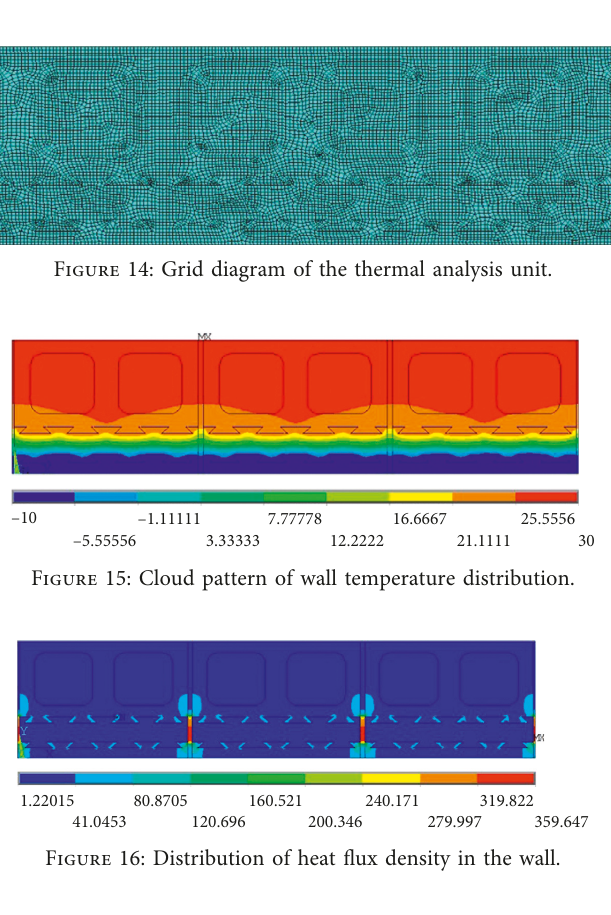
Figure 13: Geometric model of the thermal analysis unit.